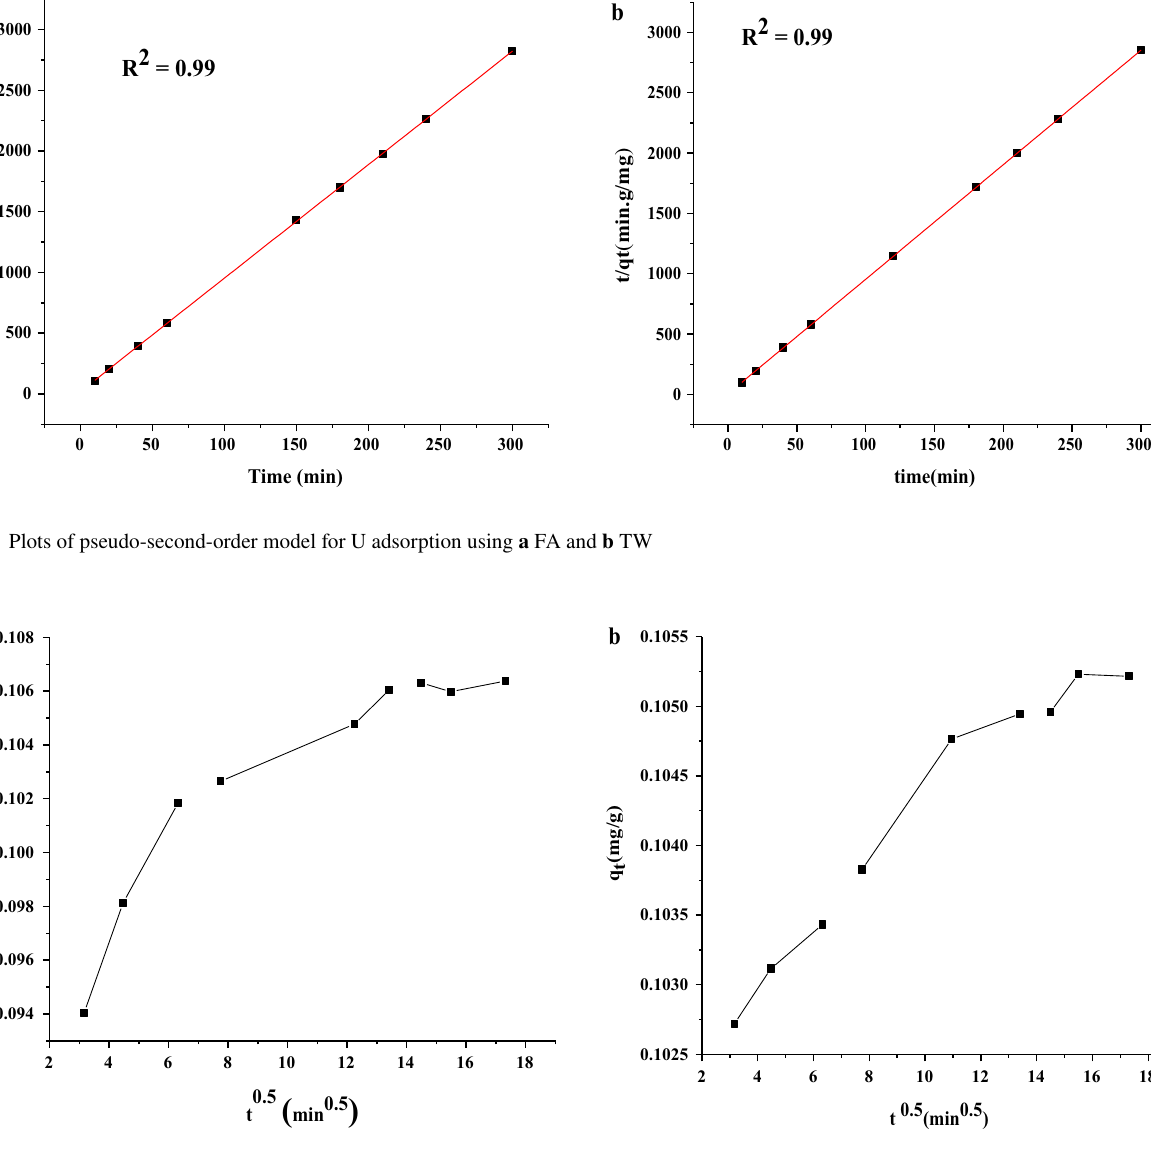
Fig. 4 Intra-particle diffusion model plot for U adsorption on a FA and b